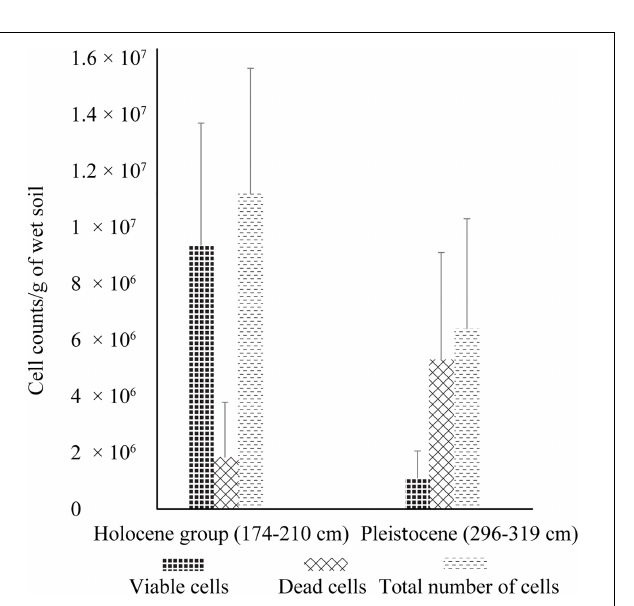
FIGURE 1 | Live/dead cell counts of Holocene and Pleistocene aged samples. Error bars represent one standard deviation from the mean ( n = 60 mean observation). For this experiment, samples from 174–210 cm ( n = 4) and 296–319 cm ( n = 4) were selected to investigate cell viability in Holocene aged and Pleistocene aged soils. These depths were selected based on their close proximity to the Pleistocene-Holocene transition zone of 244 cm. The statistical significance (Student’s t -test) of fold change in cell counts from Holocene to Pleistocene is as follows: fold change in viable cells ( p < 0.001), fold change in dead cells ( p < 0.001), and fold change in total cells ( p <